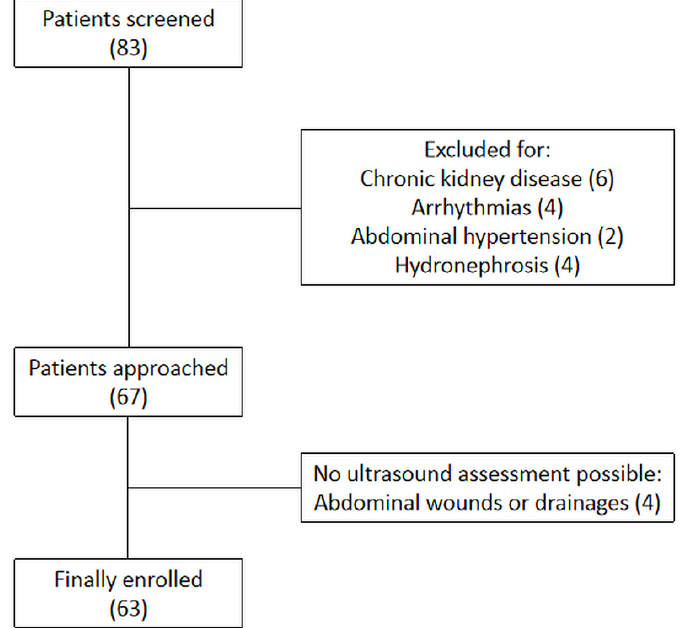
Figure 2. Flowchart of studied patients. Table 1. Clinical characteristics, laboratory data and intrarenal Doppler parameters at ICU admis ‐ sion according to KDIGO stage at day 5.